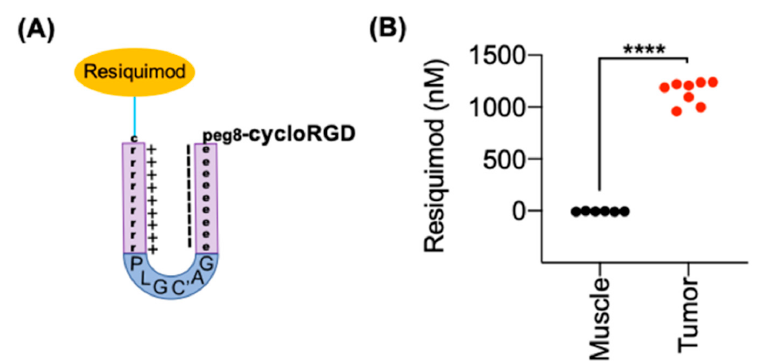
Figure 5. ACPP selectively delivers resiquimod to tumor tissue. ( A ) Structural representation of resiquimod conjugated to ACPP. ( B ) Resiquimod drug concentrations within tissue. Mice with B16 tumors intravenously (i.v.) injected with ACPP-resiquimod. Tumor and muscle drug concentra- tions quantitated by LC-MS/MS. Individual tissue concentrations plotted from muscle and tumor. **** P < 0.0001.